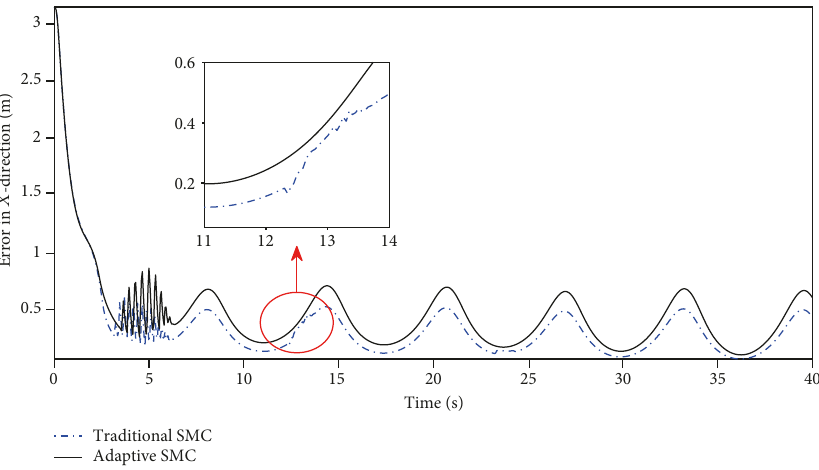
Figure 9: The comparison of errors in X -direction with SMCs.